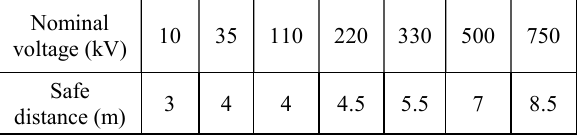
Table 4. Power safety distance